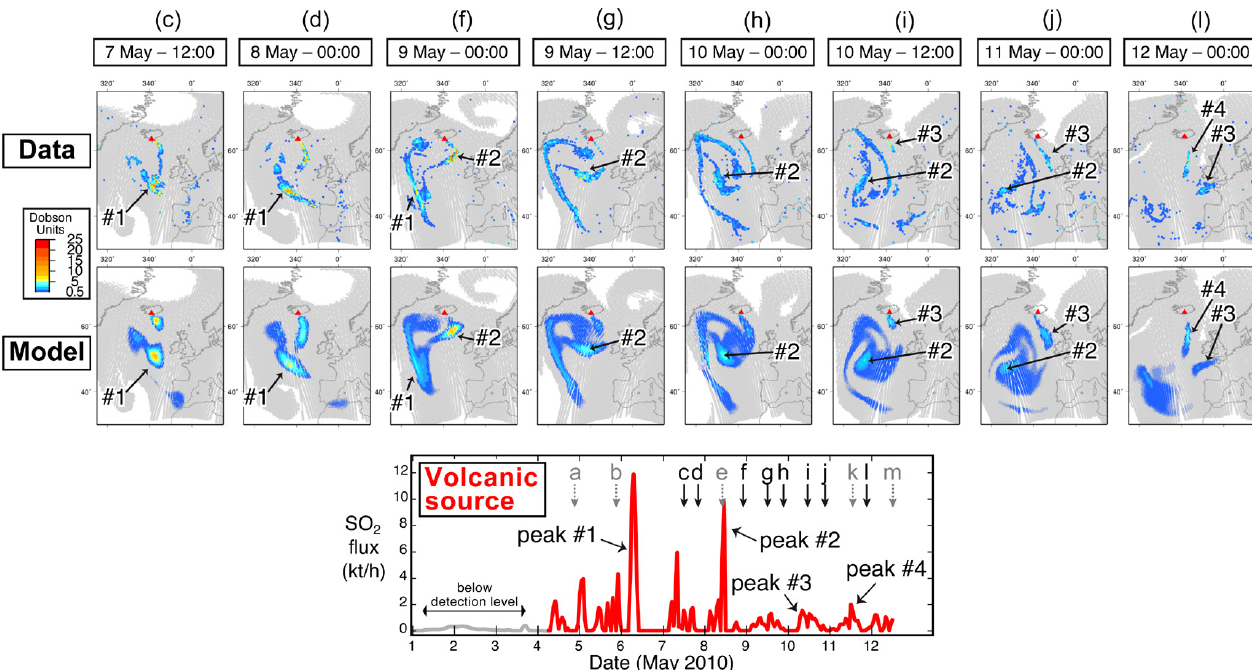
Fig. 5. Comparison of observed and modelled atmospheric evolution of the Eyjafjallaj¨okull plume in May 2010. Data: maps of SO 2 column amounts (CA in DU) derived from the processing of IASI satellite observations acquired over a 12h time window, centred on the date indicated above. Model: maps of SO 2 CA simulated with CHIMERE chemistry-transport model, using the source reconstructed by multiple- image inversion (bottom plot). Regions in grey indicate column amounts less than 0.5DU, which corresponds to the detection threshold in IASI processing (see Sect. 2.2 for details). Source: time series of the SO 2 flux (kth − 1 ) retrieved from the inversion procedure using the 13 IASI images available for the period from 1 to 12 May 2010 (numbered (a) to (m) and indicated with arrows). The complete time series of observed and modelled maps is available in the Appendix (Figs. A1 and A2). As illustrated by a few examples, peaks in the SO 2 flux create dense puffs in the plume which can be tracked up to 6 days after their